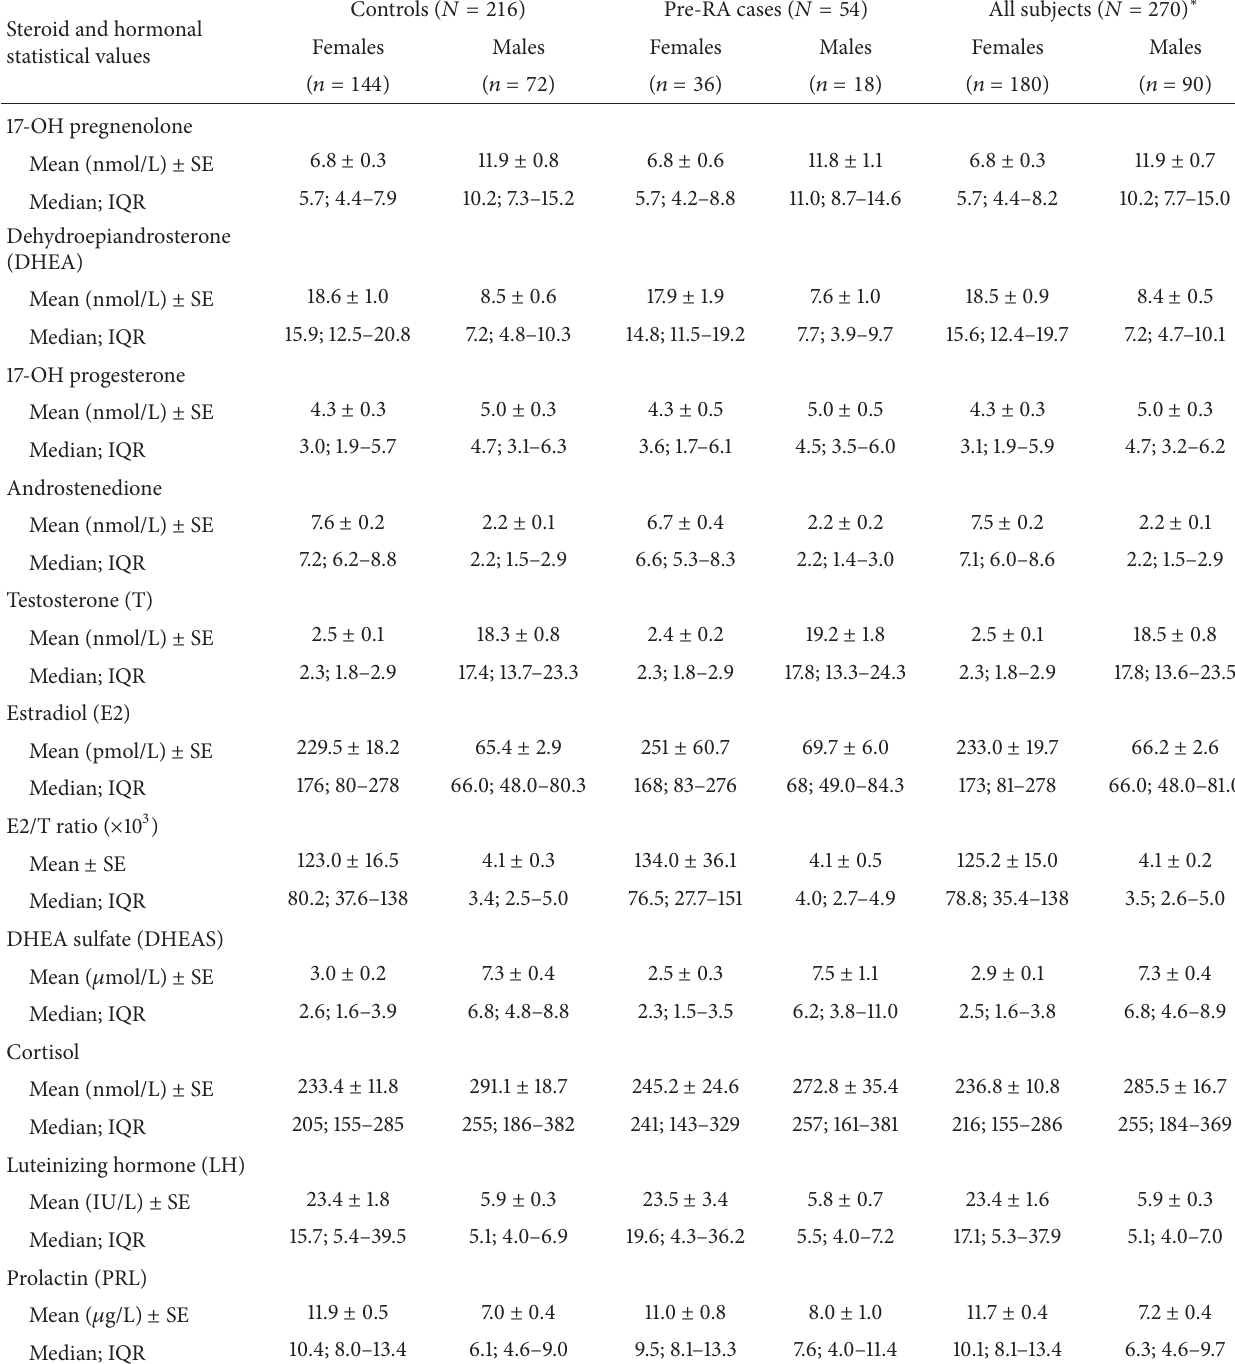
Table 3: Steroidal and hormonal values reported by referral laboratory and imputed to full sample sizes. Steroid and